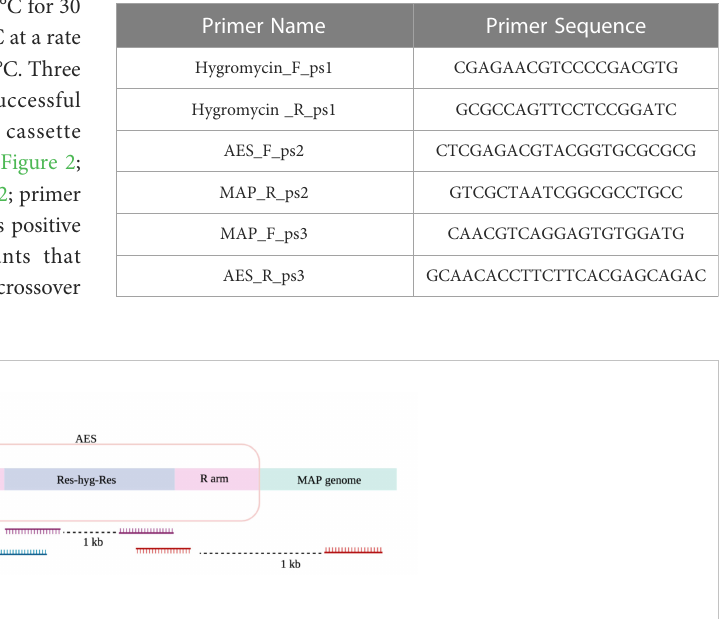
FIGURE 2 PCR primer schematic for MAP recombination screening.